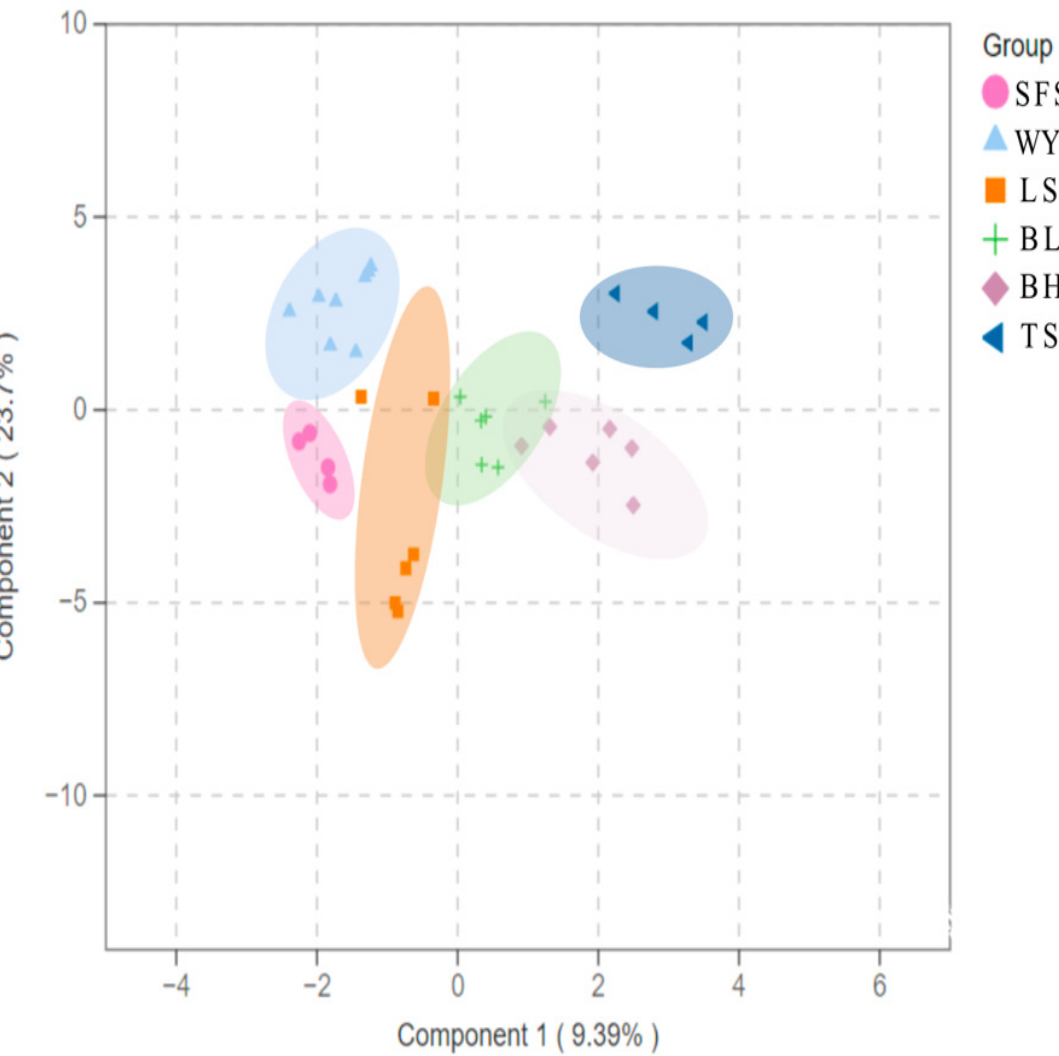
Figure 5. OPLS-DA score plot of secondary metabolites at different latitudes of T. amurensis. Different colors represent different sampling points.